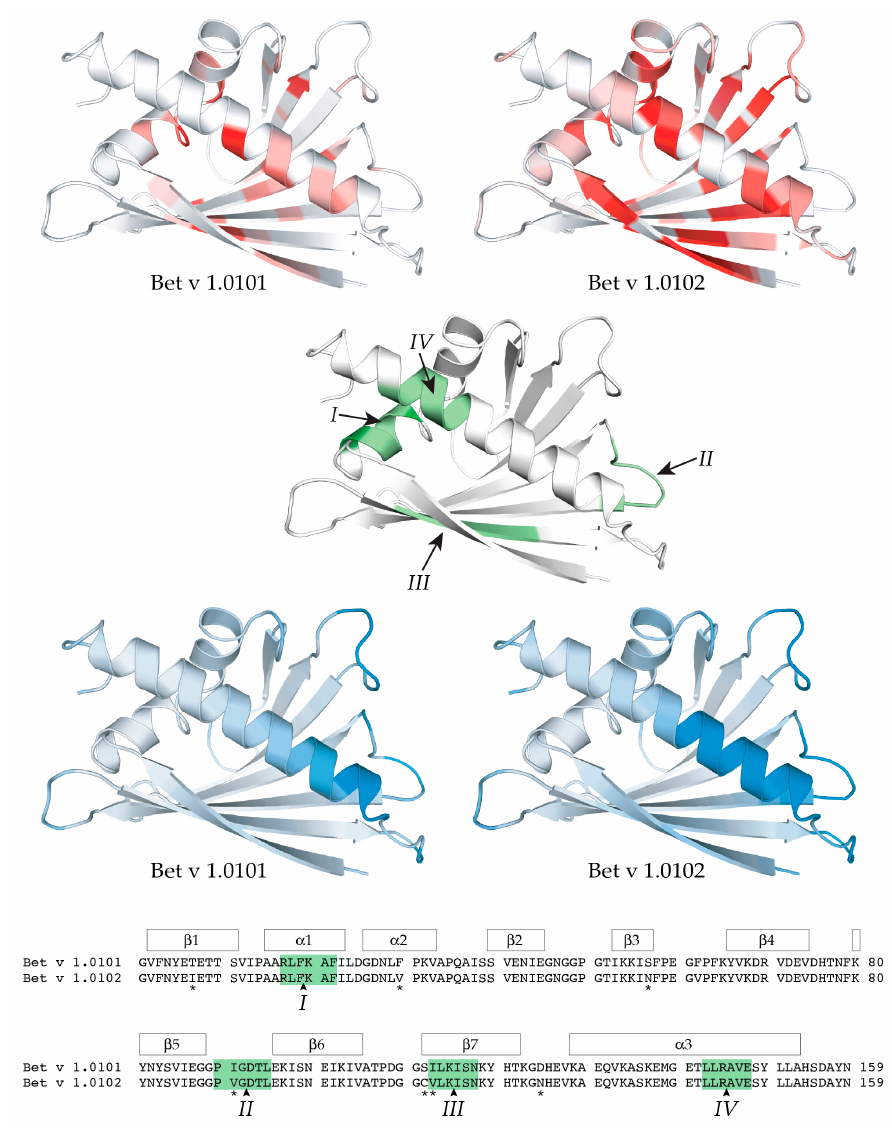
Figure 4. Conformational flexibilities of Bet v 1 isoforms Bet v 1.0101 and Bet v 1.0102. Top: Site-specific microsecond-millisecond time scale flexibilities ( R ex values) derived from NMR relaxation dispersion experiments, colored from red (high flexibility) to white (low flexibility). Bottom: Site-specific nanosecond-microsecond flexibilities (B-factors) from MD simulations, colored from blue (high flexibility) to white (low flexibility). For both isoforms, identical color thresholds were used. Center: Early proteolytic cleavage sites I – IV according to Freier et al. [13]. Protease recognition sites between the non-primed site P3 and the primed site P3’ are shown in green (site I : Arg17-Phe22, site II : Pro90-Leu95, site III : Ile113-Asn118, site IV : Leu143-Glu148) and the scissile peptide bonds are marked by black arrows. Bottom: Sequence alignment of Bet v 1.0101 and Bet v 1.0102 obtained with Clustal Omega [25]. Secondary structure elements (Bet v 1.0101) are indicated and early proteolytic cleavage sites I – IV are displayed in green . Sequence differences between Bet v 1.0101 and Bet v 1.0102 are marked with asterisks.